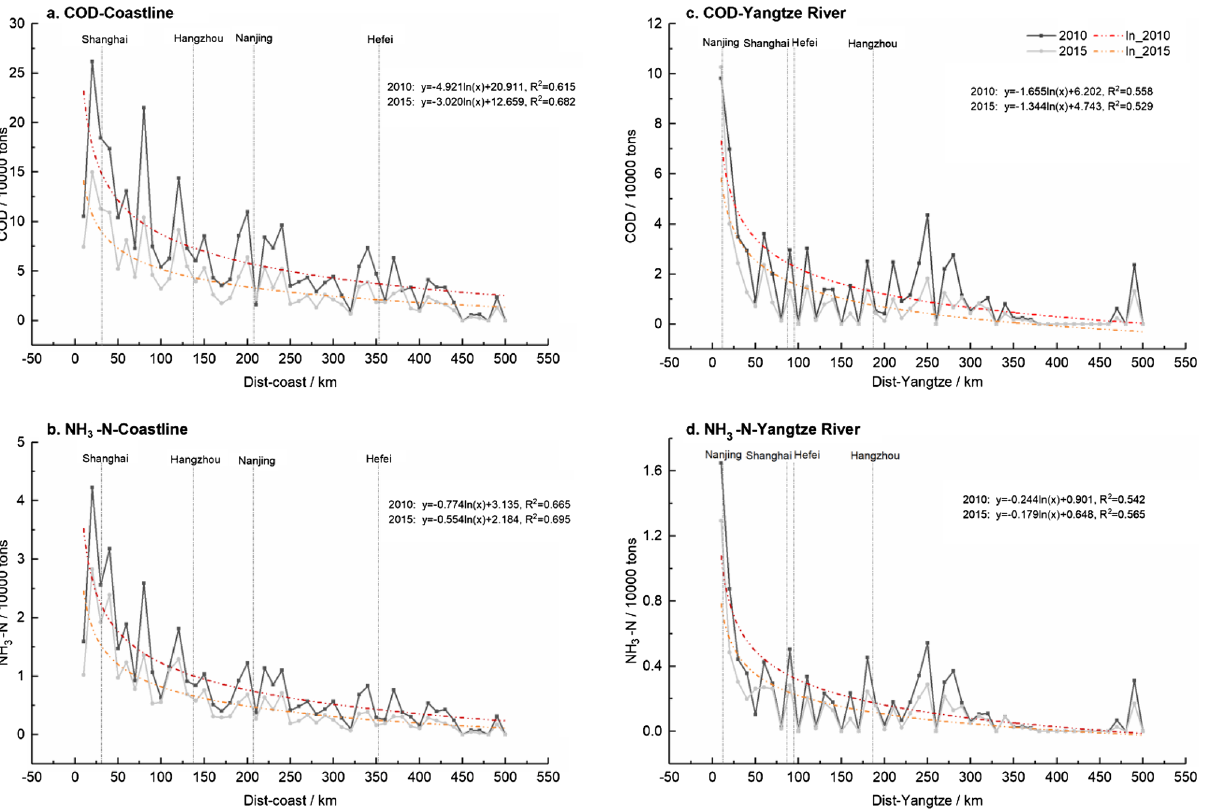
Figure 3. Water pollutant emissions of counties by distance from coastline or the Yangtze River